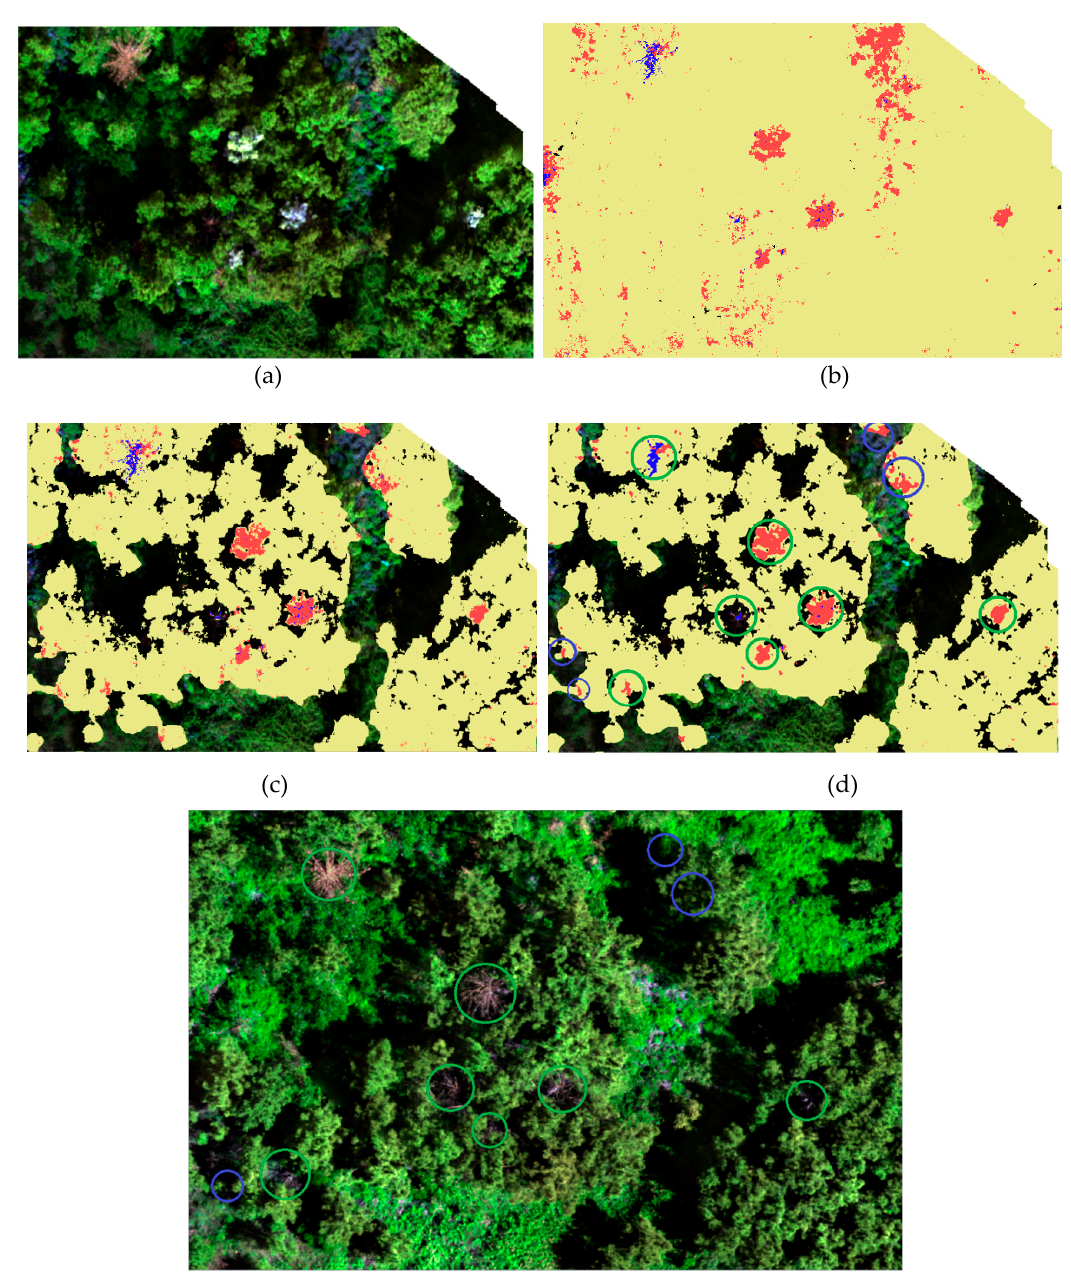
Figure 12. Highlighting infected trees via classification and postprocessing of the obtained maps: ( a ) RGB representation derived from the MS data; ( b ) classification map; ( c ) classification map after removing shadows and low canopy height model (CHM) values; ( d ) classification map after spatial postprocessing; ( e ) visual confirmation of detection accuracy: the trees detected as suspicious in October 2018 are dead by June 2019. Color code of classified pixels: blue = infected, red = suspicious, yellow = healthy.